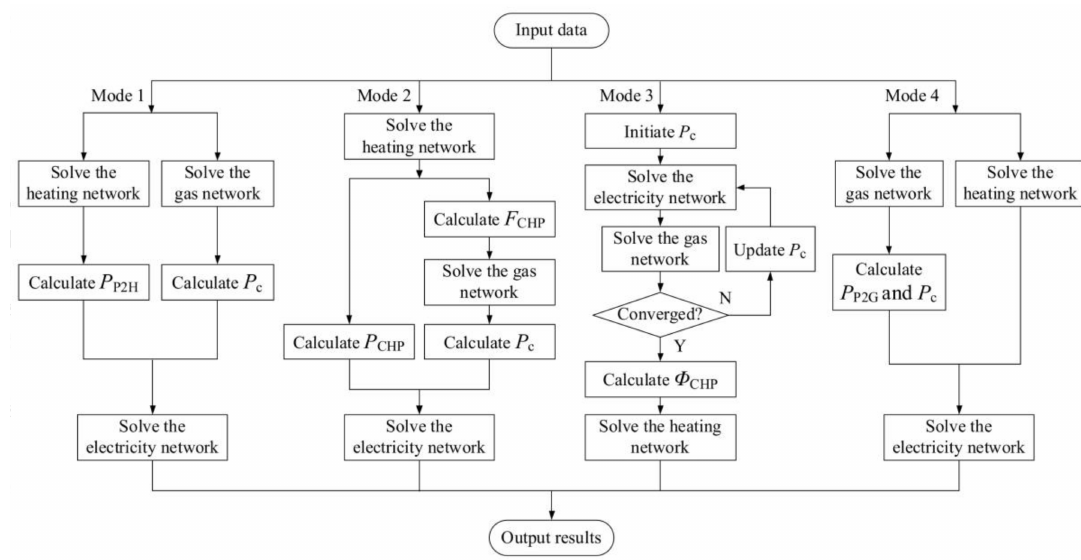
Figure 3. Flowchart for solving the DEF problem of an